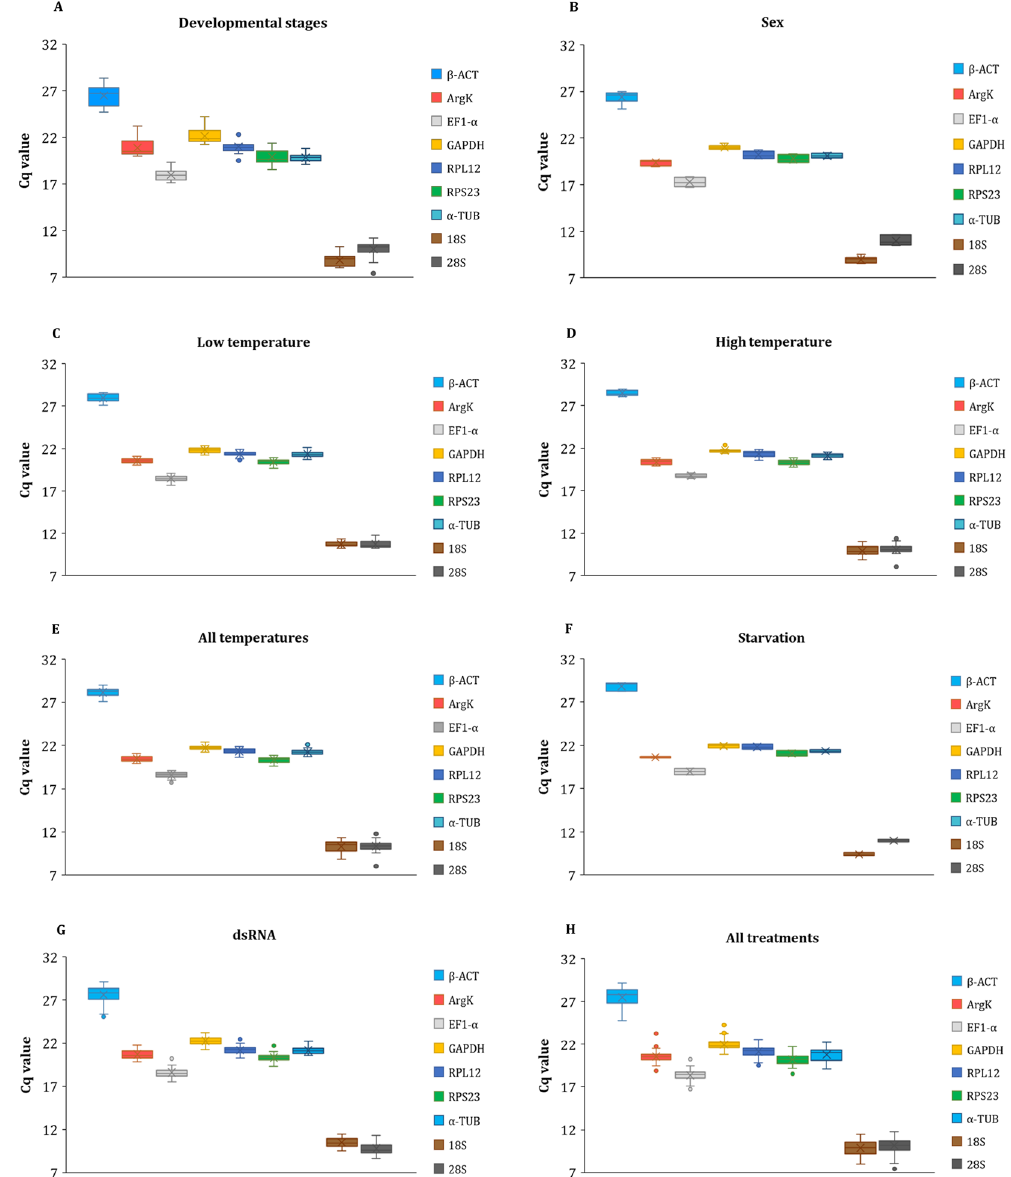
developmental stages ( A ), sex ( B ), low temperature ( C ), high temperature ( D ), all temperatures ( E ), starvation ( F ), dsRNA ( G ) and in all treatments ( H ). The upper and lower edges of the boxes indicate the 75th and 25th percentiles, respectively. Whiskers represent the minimum and maximum Cq values, the line and the x within the box marks indicate the median and mean, respectively. Small circles indicate the